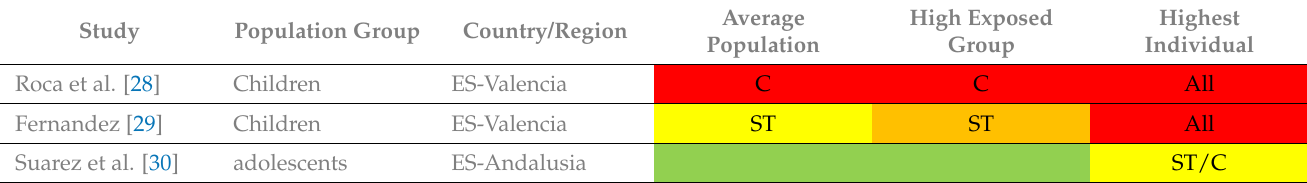
Table 5. Graphic representation of the identified risk levels. Color code: RED: confirmed concern; ORANGE: possible concern (only applicable to OA and ST); YELLOW: concerns cannot be excluded; GREEN: risk cannot be excluded due to the concerns on genotoxicity but is expected to be very